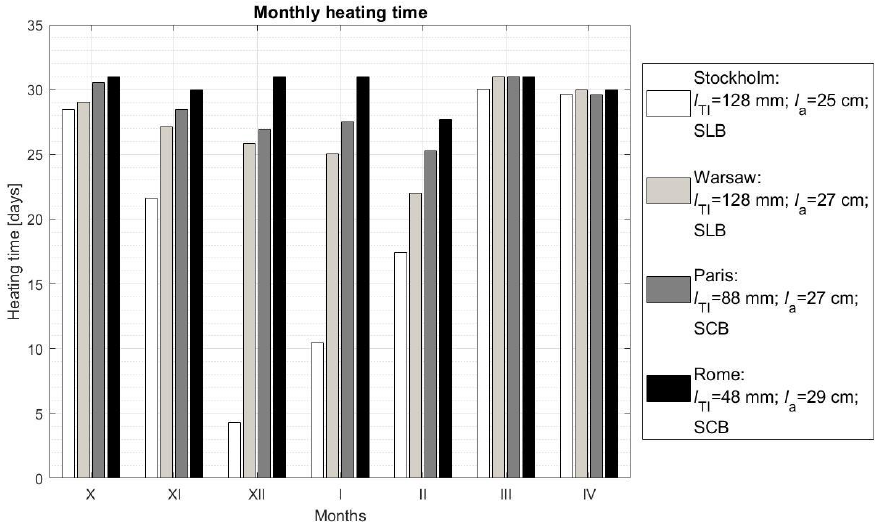
Figure 13. Comparison of monthly heating times for the SWs with the TI thickness and AL parameters and materials proposed for the considered locations.